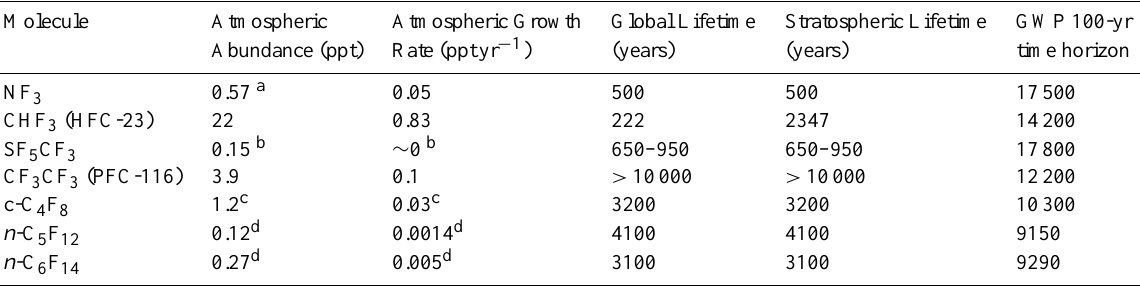
Table 1. Summary of atmospheric abundance, growth rate, lifetimes, and global warming potential (GWP) for the molecules included in this study as taken from WMO (2011) for the year 2008 unless noted